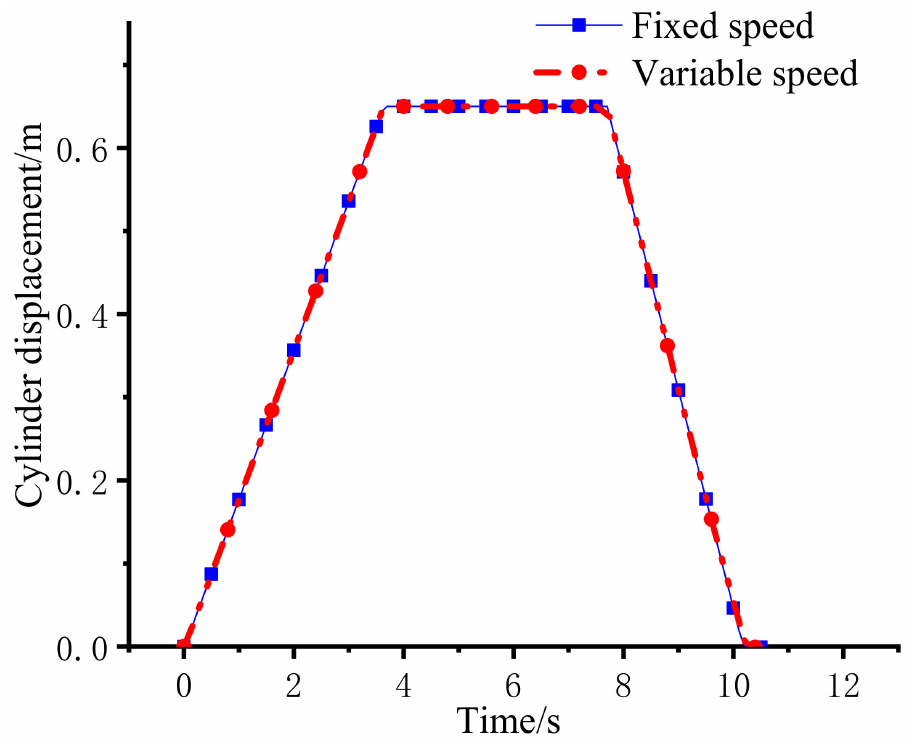
Figure 15. Displacement curve of the cylinder simulating boom lifting and lowering in the con- stant/variable speed systems.